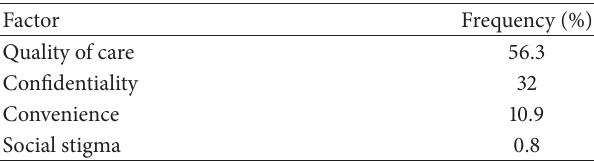
Table 3: Most important factors influencing top pick for outpatient treatment.